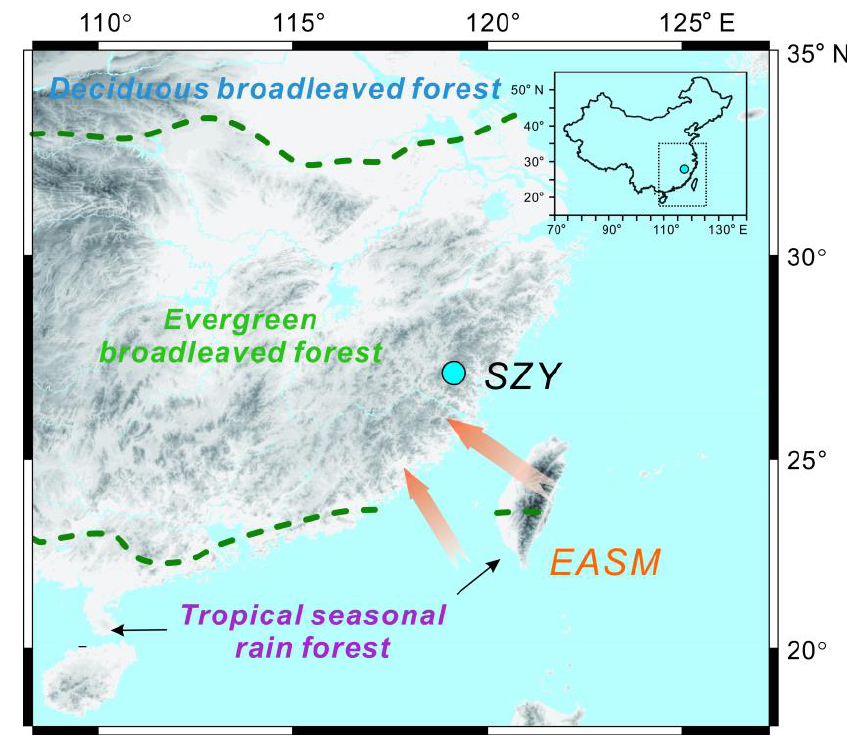
Figure 1. Location of the study core SZY.